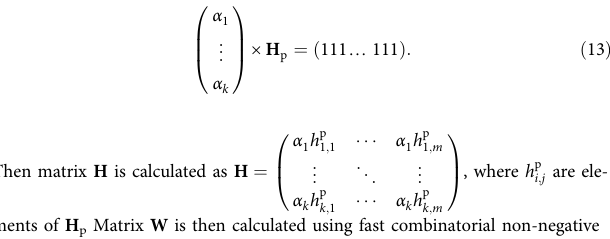
below in detail: Row